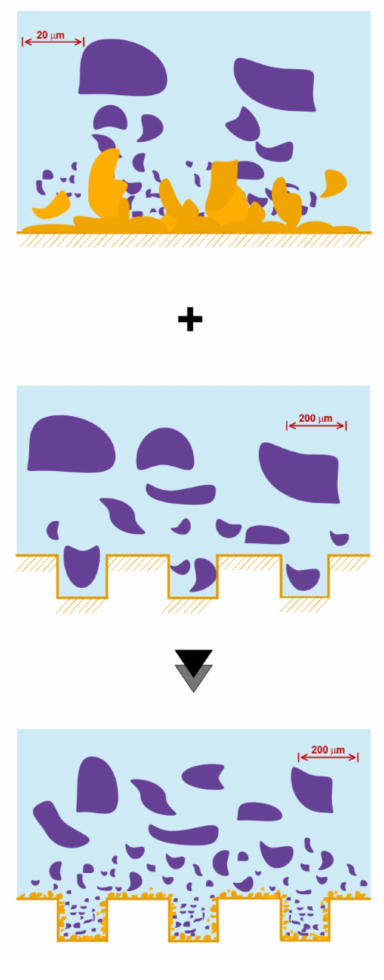
Figure 19. Schematic of bubble dynamics on porous, mesochannel and combination of them in low heat flux